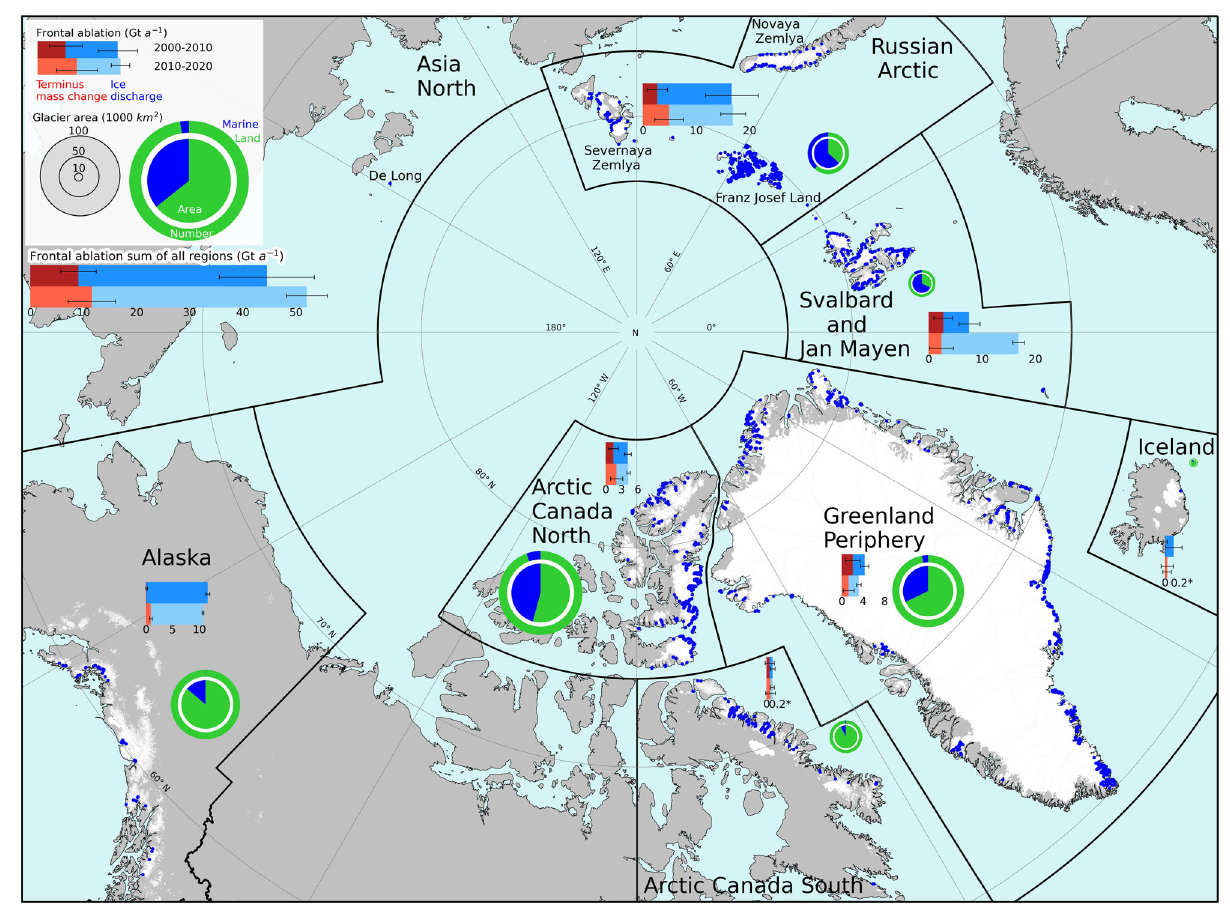
Fig.1|Regionalfrontalablationofmarine-terminatingglaciers. Barchartsshow thedecadal-meanfrontalablationratesbyNorthernHemisphereregionfrom2000 to2020andaredividedintoicedischargeandterminusmasschange(uncertainties